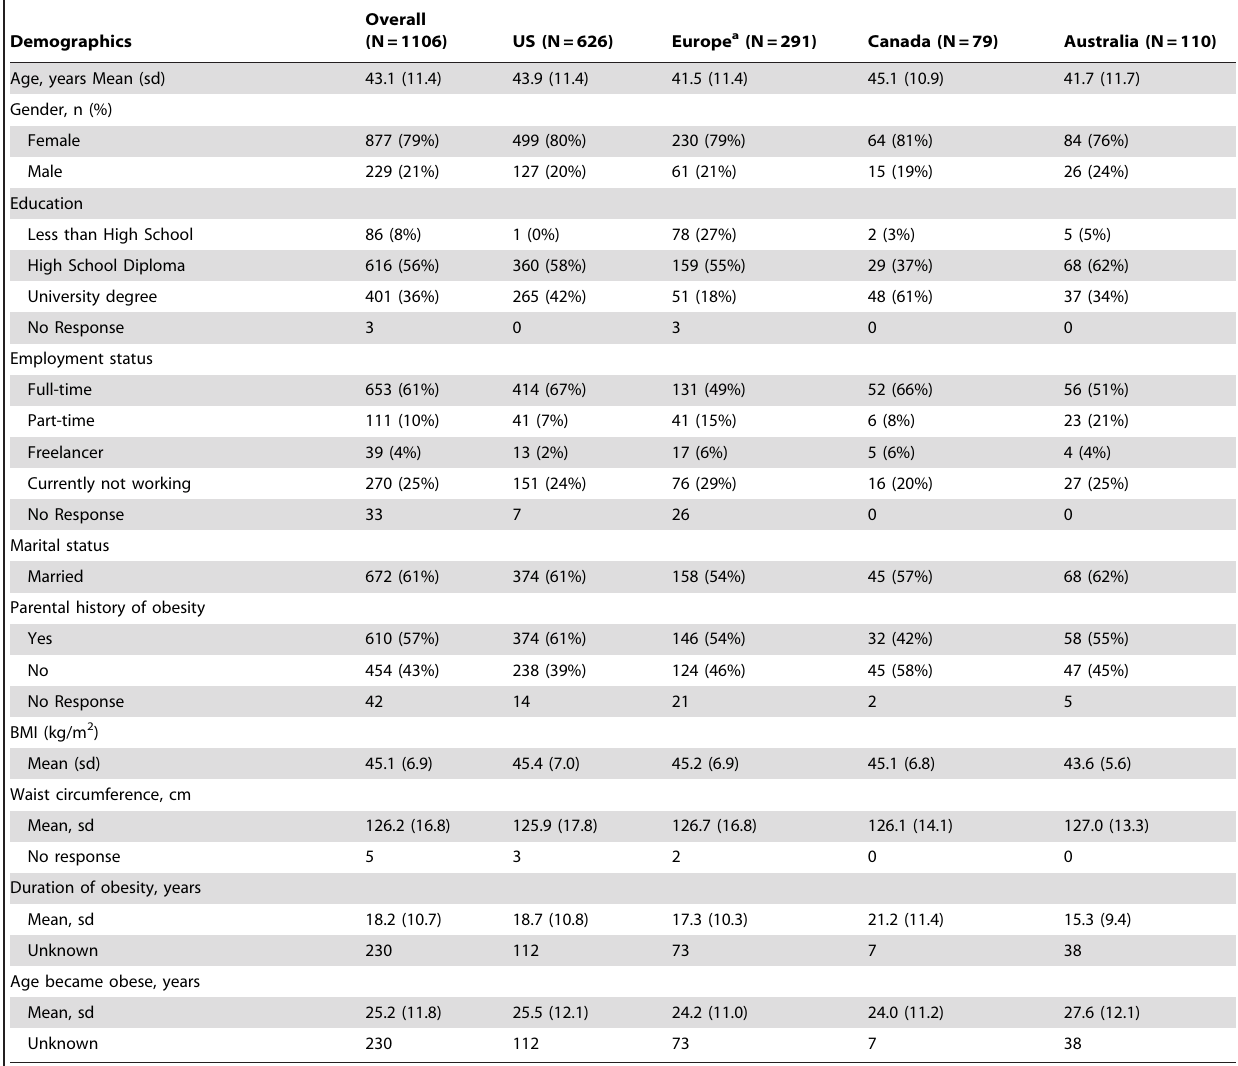
Table 2. Key Demographic Variables by